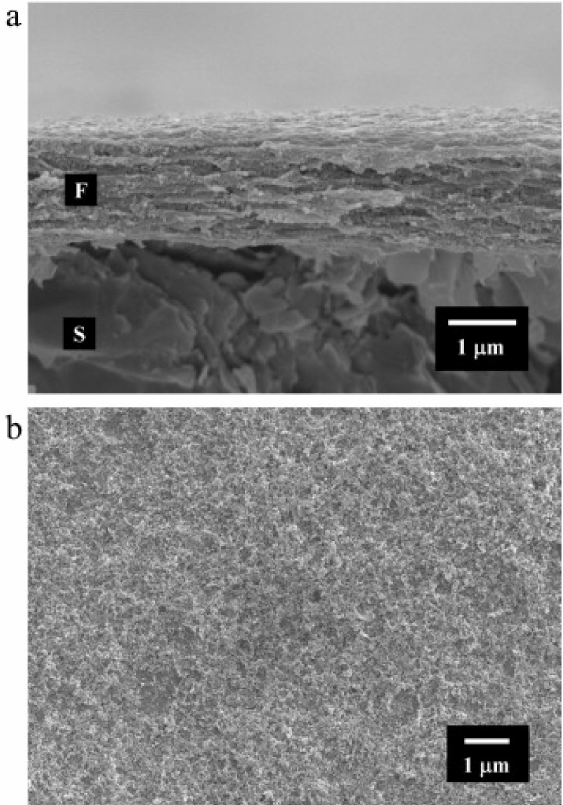
Figure 8. SEM images of ( a ) a cross section (fracture) and ( b ) the surface of a film prepared by EPD from